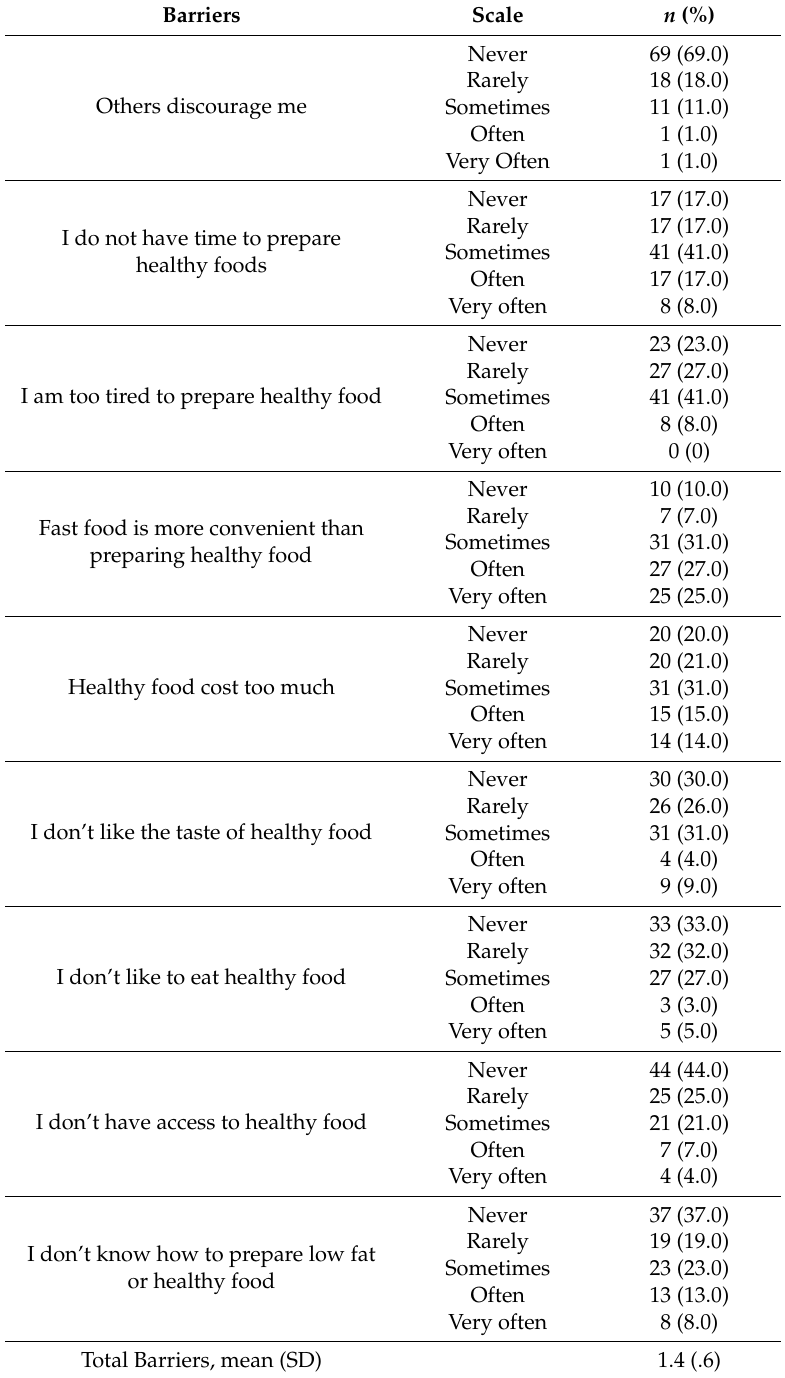
Table 3. Participants’ self-reported barriers to healthy eating ( n =